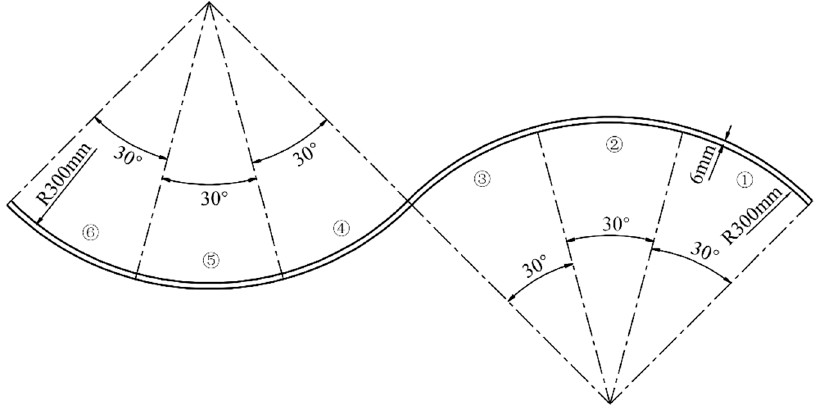
Figure 14. Coding of S-shaped weldment.